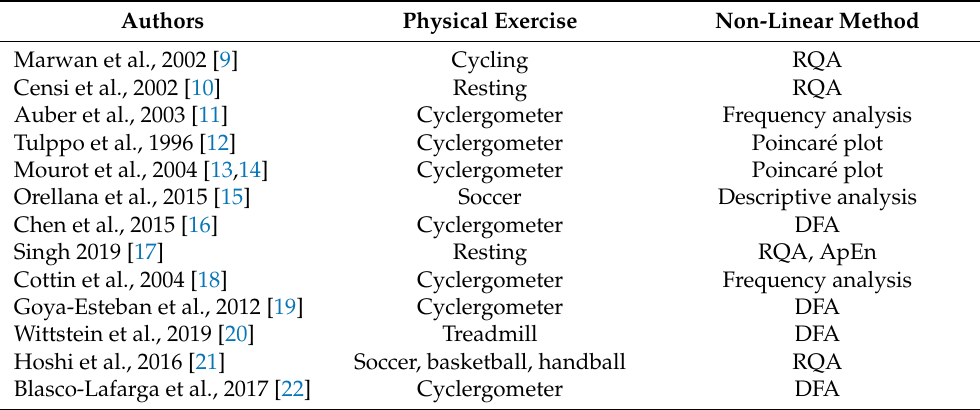
Table A1. Research article reporting relationships between HR time series features and physical